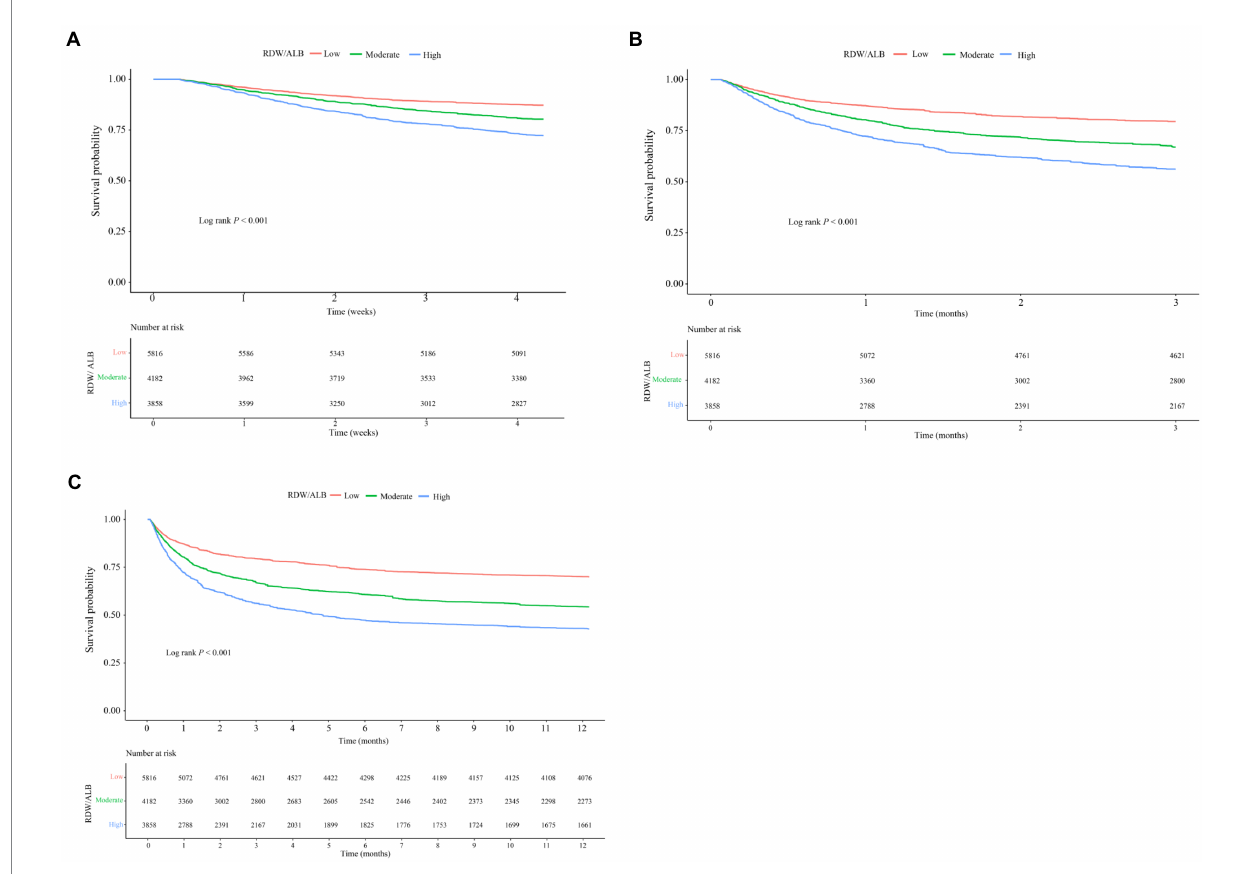
FIGURE 3 Kaplan–Meier (KM) survival curves of 1-month (A) , 3-month (B) , and 12-month (C) in patients with low, moderate, and high RDW/ALB ratios.